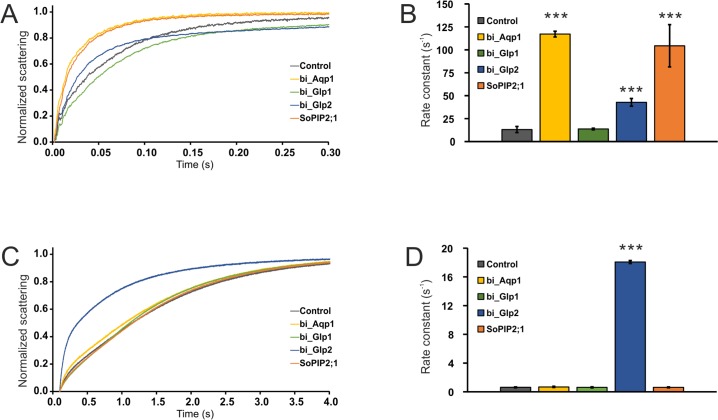
Functional analysis of AQP proteins.The B. improvisus aquaporins Aqp1, Glp1 and Glp2 were heterologously expressed in the yeast P. pastoris, purified and reconstituted into liposomes. The spinach aquaporin SoPIP2;1 was included as control. The transport of water and glycerol out of the proteoliposome vesicles were measured as light scattering (indicates liposome swelling/shrinkage) using stopped flow spectroscopy measured at 436 nm. For each experiment, at least three traces were averaged and fitted to either single or double exponential functions using the method of least squares. One typical stopped flow spectroscopy trace is displayed. Reported rate constants are an average of three independent measurements. Error bars show standard deviation.*** = significantly different from control (ANOVA, p<0.001). A-B) water transport. C-D) glycerol transport. The y-axis in B and D shows the rate constant for the curve fitted to the data.